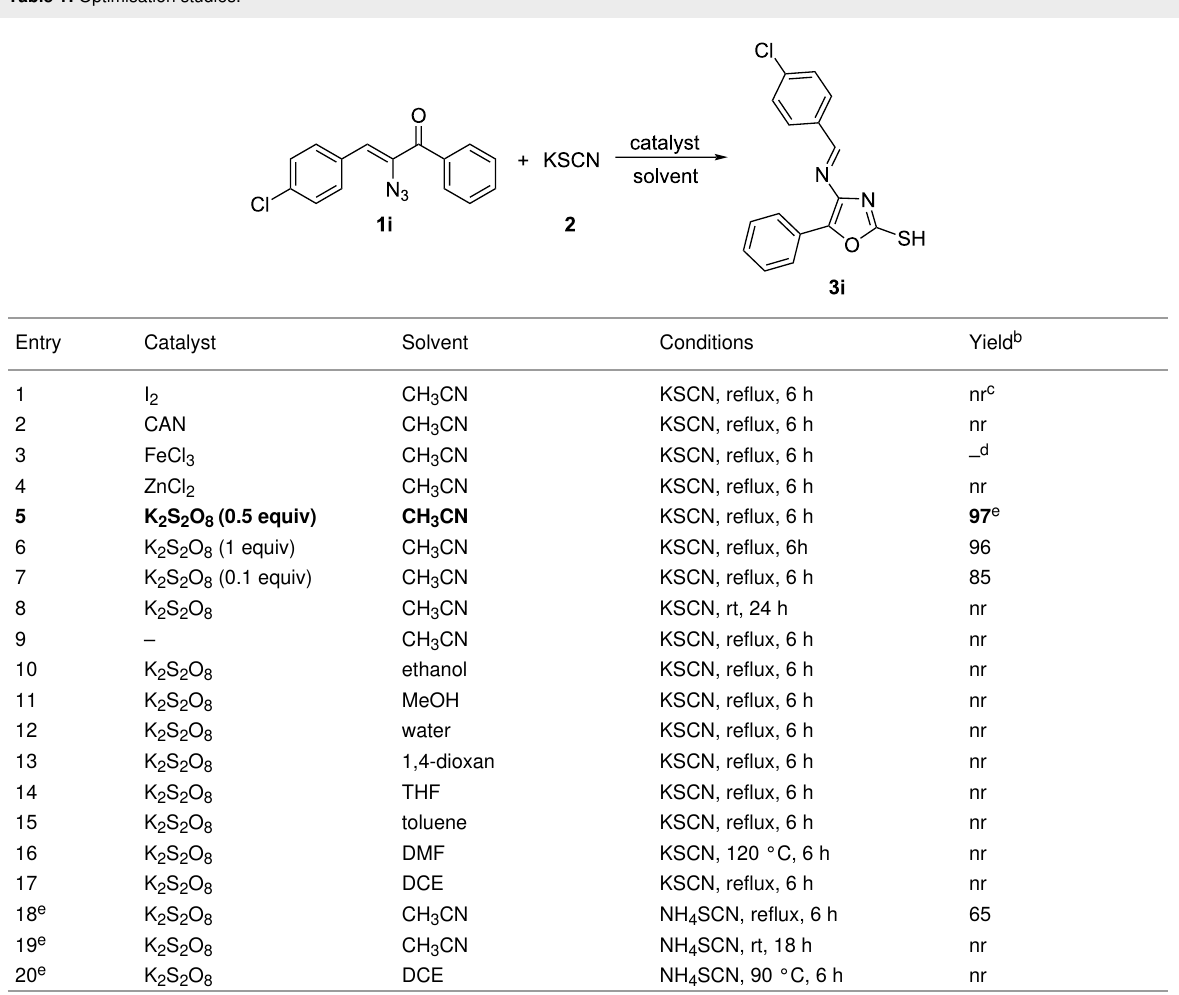
Table 1: Optimisation studies.